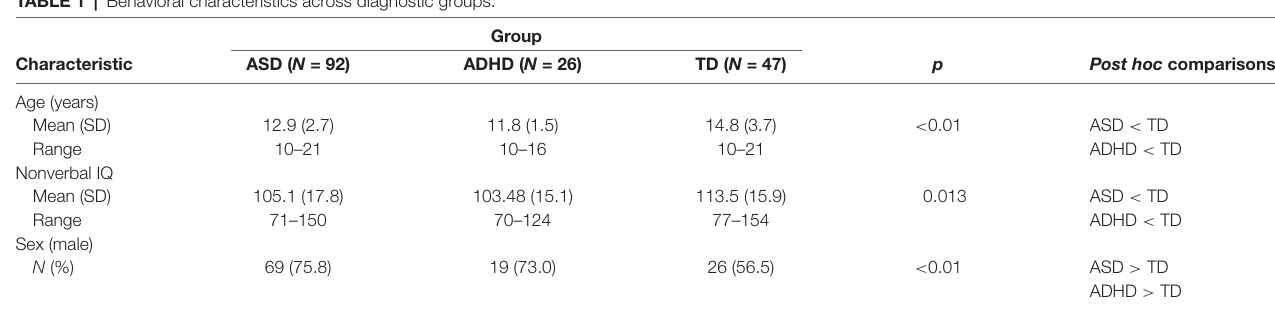
TABLE 1 | Behavioral characteristics across diagnostic groups.